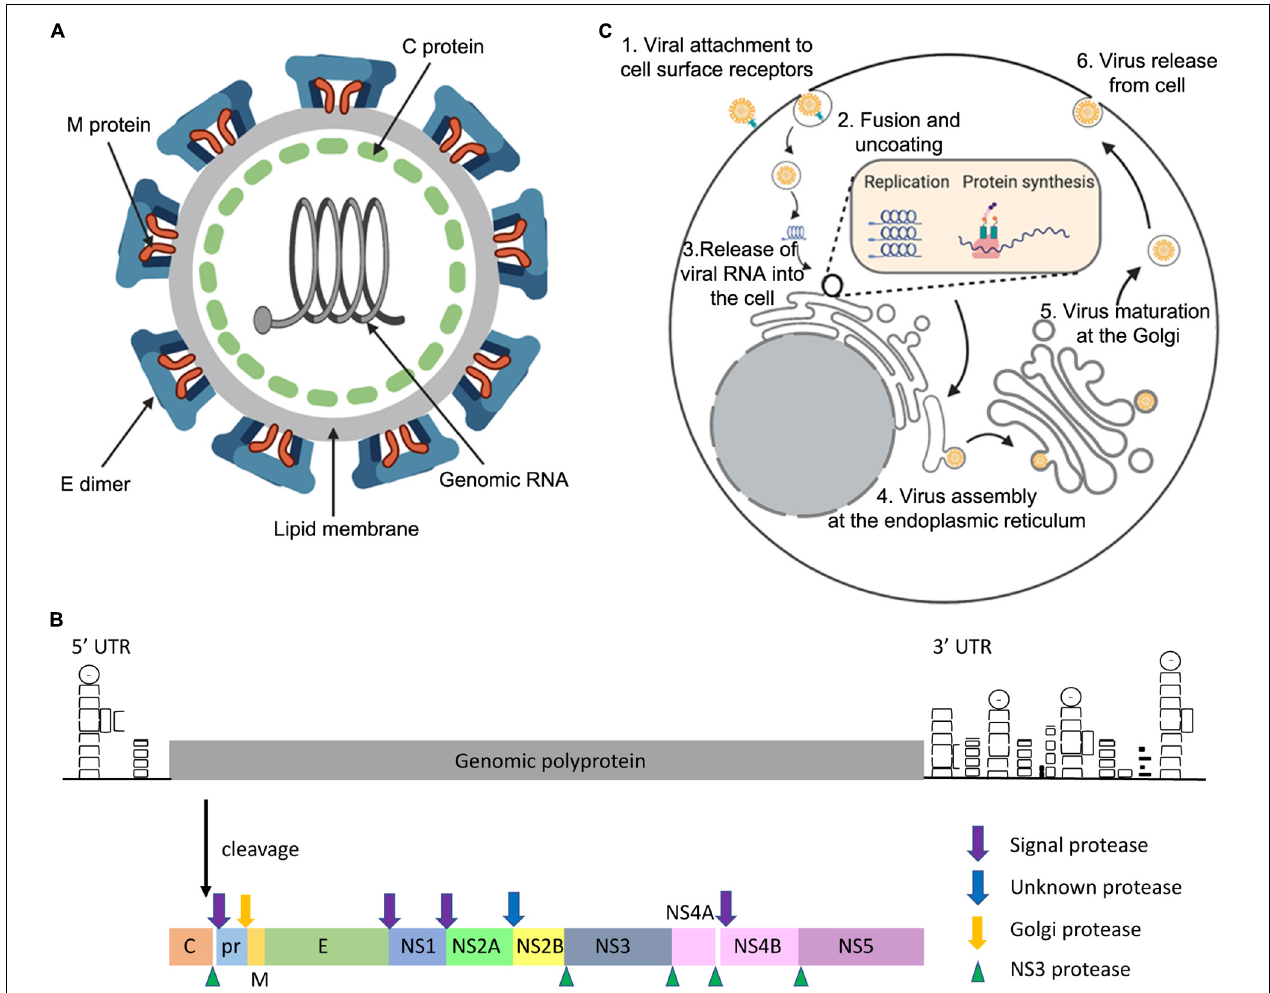
FIGURE 1 | General features of the ZIKV. The ZIKV virion (A) is an enveloped, spherical virus about 50 nm in diameter. The surface proteins envelope (E) and membrane (M) are arranged in an icosahedral structure that encases the nucleocapsid (C) protein bound to the viral RNA (adapted from viralzone.com and created with Biorender.com). The genome (B) is positive sense single-stranded RNA consisting of a single open reading frame, and 5 (cid:48) and 3 (cid:48) untranslated regions. The single synthesised polyprotein is post-translationally cleaved by host proteases (signal and Golgi peptidases) and the viral NS3 protease. This forms the three structural proteins: C, pre-membrane (prM), and E. Additionally, there are seven non-structural proteins which are necessary for genome replication and the modification of host cellular functions (adapted from Pierson and Diamond, 2018). (C) ZIKV enters the host cell using receptor mediated endocytosis via the receptors DC-SIGN, Tyrosine 3, TIM-1 or ACL. ZIKV is then translocated via endosome vesicles to the ER, and viral RNA is released. Translation occurs and the resulting polyprotein is subsequently cleaved using host and viral proteases. ZIKV remodels the ER and uses viral replication factories to carry out genome replication. Immature virions then assemble on the ER derived membrane, undergo maturation at the Golgi, and are released from the cell using the secretory pathway (adapted from Gerold et al., 2017, created with